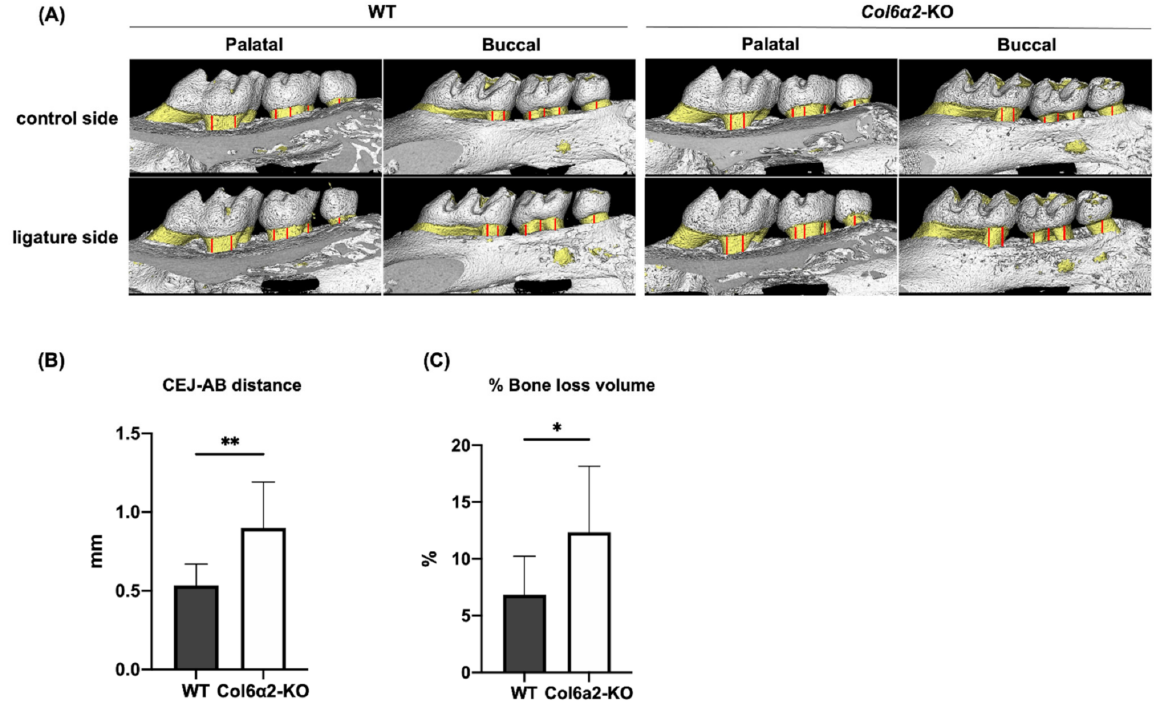
Figure 5. Alveolar bone loss with periodontitis. ( A ) Representative 3D reconstructed image of left molars in maxilla (control side) and right molars in maxilla (ligature side). To evaluate bone loss, the distance between the cemento-enamel junction (CEJ) to the alveolar bone crest ( A , B ) was measured at 12 separate points in both the buccal and palatal sides. The red line in ( A ) shows the measurement points. ( B ) shows the difference of the CEJ-AB distance in the control side and the ligature side from WT and Col6 α 2 -KO mice. ( C ) shows the % volume of bone loss. Bars represent standard deviation ( n = 9/genotype) p -value: * p < 0.05, ** p <